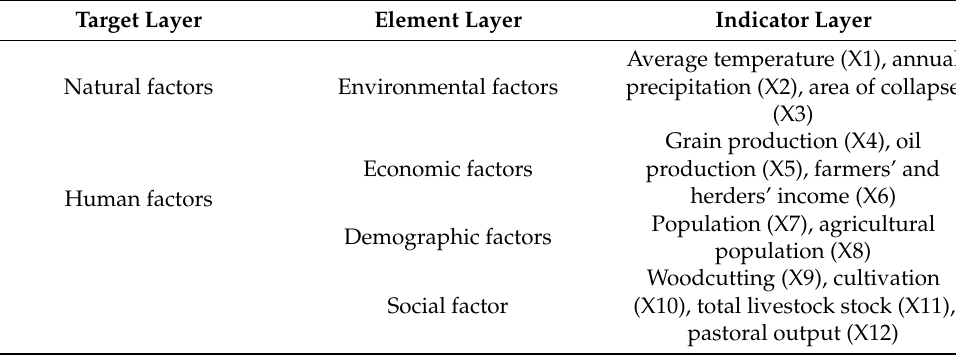
Table 6. Malus sieversii forest‘s Driving Force Index System in the Mohe